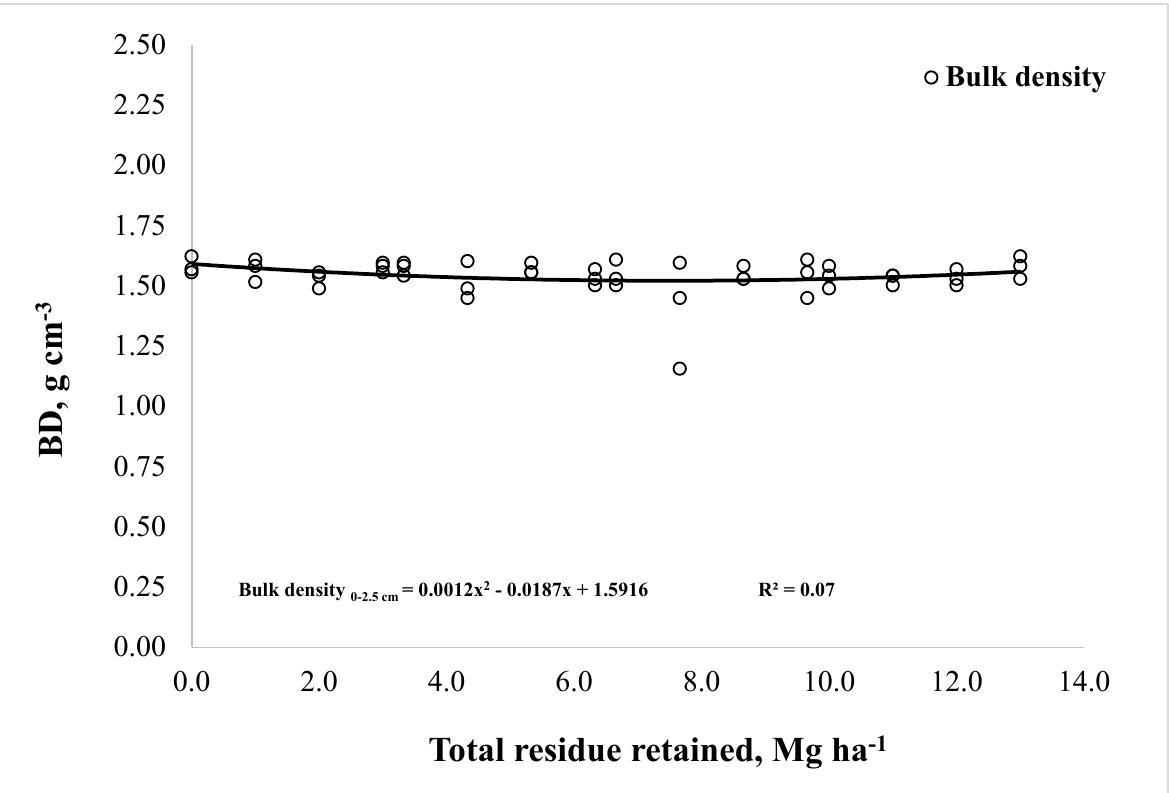
Figure 3. Bulk density (g cm − 3 ) at the 0–2.5 cm soil depth in a factorial design of sixteen total residue retained rates (in Mg dry matter ha − 1 ) from corn and wheat in a corn-wheat/soybean rotation in 2017 in New Kent, experiment 1 (NK1), Virginia. Polynomial best fit line, quadratic equation and R-square value are presented in the figure.